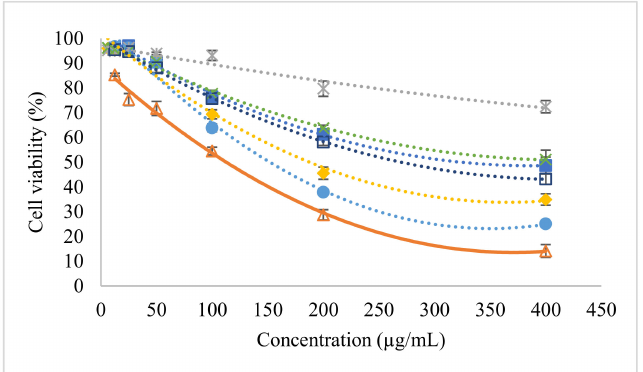
Figure 7. MCF-7 cell viability after treated with tamoxifen ( ∆ ), crude extract ( (cid:4) ), crude precipitate (x), crude filtrate ( (cid:3) ), ethyl acetate fraction ( (cid:7) ), ethyl acetate precipitate ( • ), and ethyl acetate filtrate (